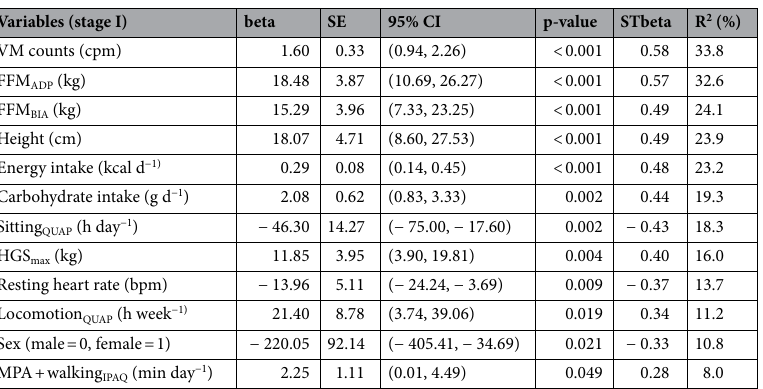
Table 3. Crude association of significant variables from stage I selection step and AEE (kcal day −1 ) using single linear regression sorted by strength of association (n = 49). ADP air-displacement plethysmography, beta unstandardized regression coefficient, BIA bioelectrical impedance analysis, bpm beats per minute, cpm counts per minute, FFM fat-free mass, FM fat mass, HGS handgrip strength, IPAQ International Physical Activity Questionnaire, MPA moderate physical activity, QUAP Questionnaire on Physical Activity on previous 12 months, R 2 coefficient of determination, SE standard error, STbeta standardized beta coefficient, VM